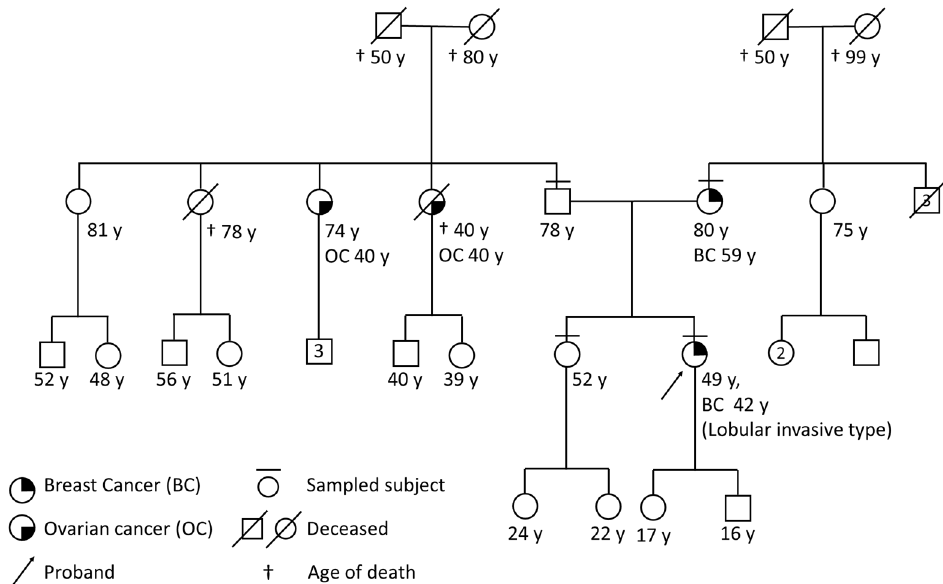
Figure 1. Four-generation pedigree of the family. The proband, III:11, was diagnosed with invasive lobular breast carcinoma at age 42. Her mother, II:6, was diagnosed with invasive ductal breast carcinoma at age 59. The proband’s paternal aunts II:3 and II:4 had ovarian cancer at age 40.